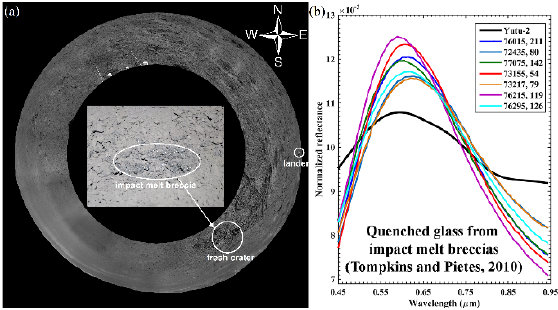
Figure 7. (a) Pancam mosaic of the unusual substance. (b) The comparison of the glassy fragments with glass quenched from Apollo impact melt breccias (Modified after Lin et al. 2020b).